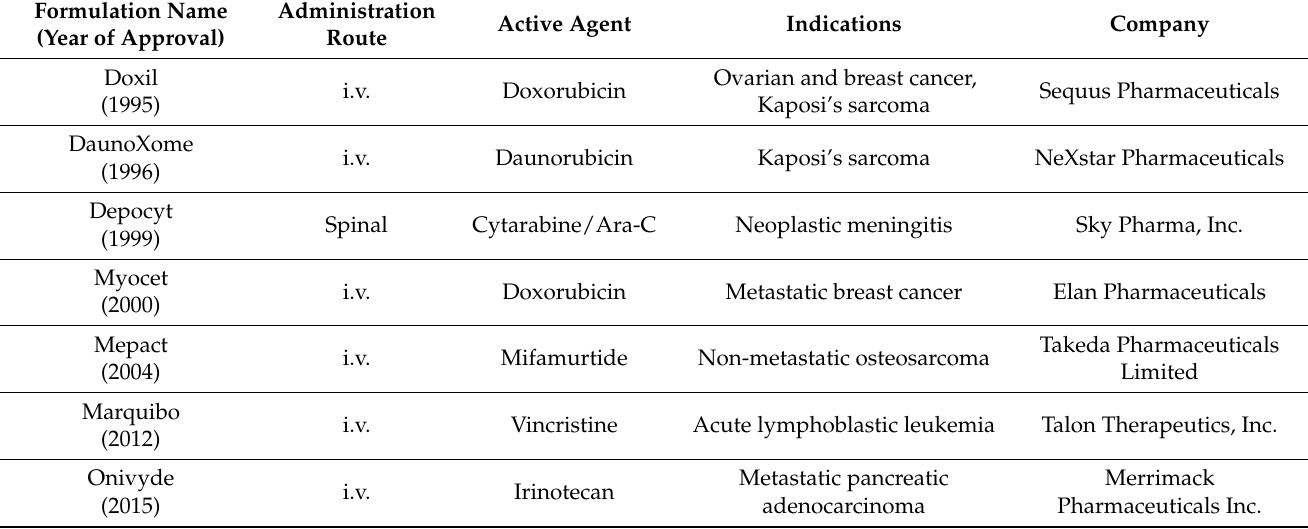
Table 1. Liposomal formulations used